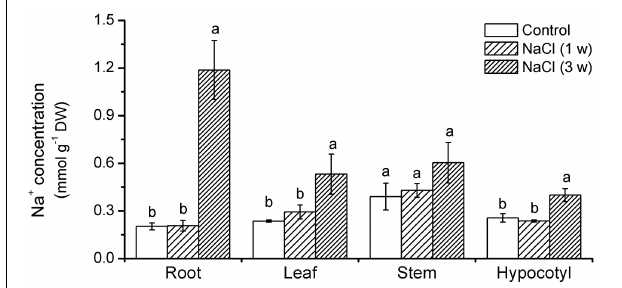
FIGURE 2 | Effects of NaCl on Na + concentrations in roots and shoots in K. candel . Plants were treated by a rising NaCl concentration from 100 to 300mM weekly for 3 weeks. Each column is the mean of 4–6 replicates. Bars represent standard error of the mean. Different letters denote significant differences at P < 0 . 05 between treatments in each organ.